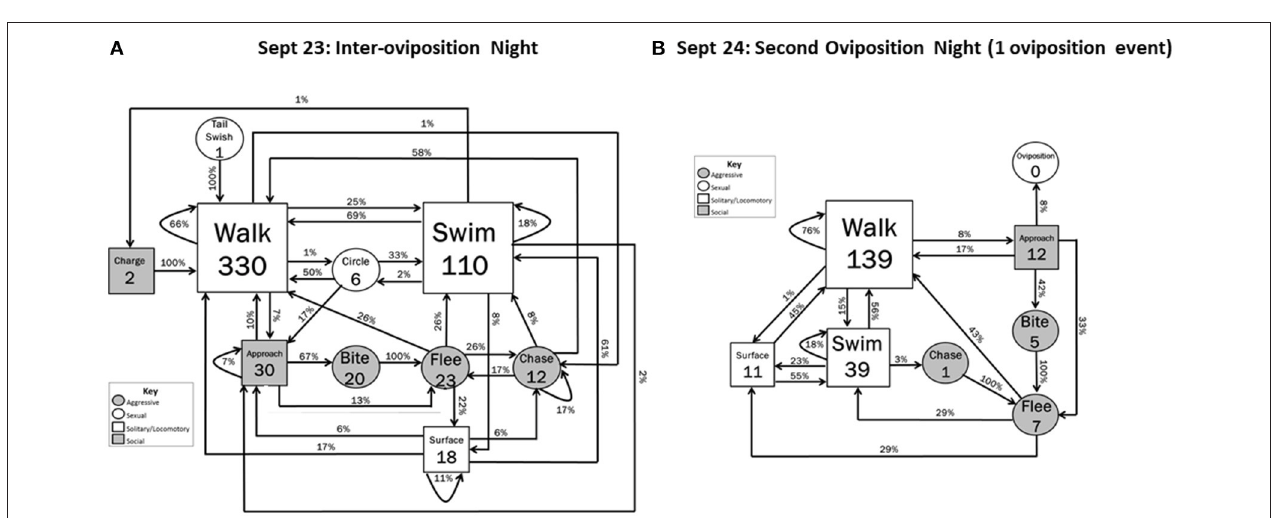
FIGURE 3 | Behavioral transitions during (A) the night between the two oviposition and (B) the second oviposition night when 1 oviposition event occurred. Frequency of initiating behavioral actions (inside boxes) and % time initiated action was followed (arrow) by other actions are indicated. Zeros indicate that the behavior occurred but did not initiate a sequence within the 5 min designated time frame. Shape sizes are indicators of the relative frequency in which the initiating behavior occurred (e.g., larger boxes indicate the behavior occurred more often than smaller